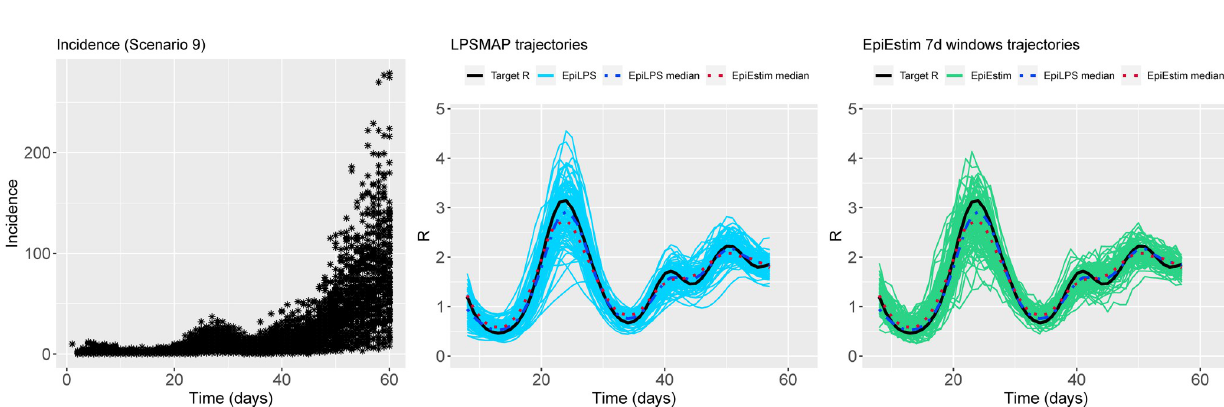
Fig 7. (Left) Simulated incidence data for Scenario 9. (Center) Estimated trajectories of R trajectories of R with EpiEstim using weekly sliding windows and R t (dashed) and EpiEstim (dotted) is also shown.